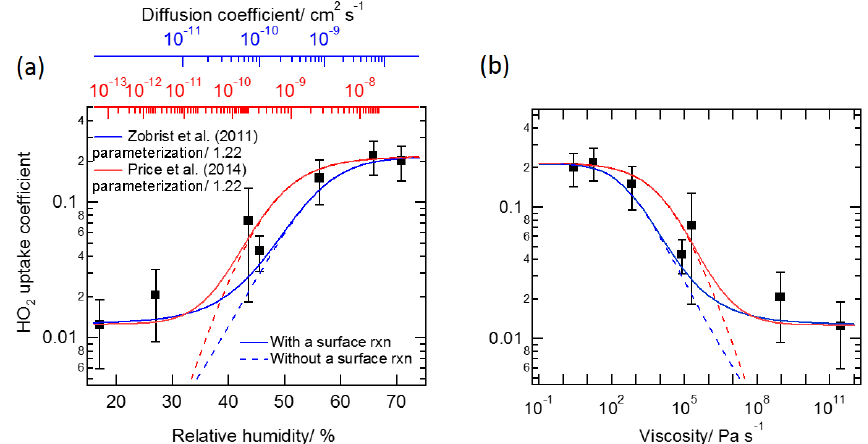
Figure 5. The HO 2 uptake coefficient onto copper (II)-doped sucrose aerosol particles as a function of (a) relative humidity and (b) aerosol particle viscosity. The lines represent the expected HO 2 uptake coefficient calculated using the KM-SUB model using the Price et al. (2014) (red) and Zobrist et al. (2011) (blue) diffusion parameterizations (see model description section) with (solid) and without (dashed) the inclusion of a surface reaction (Reaction R11). The viscosity within sucrose aerosol particles is based upon the data and fitting shown in Power et al. (2013) and Marshall et al. (2016), whilst the red and blue axes in (a) are the Price et al. (2014) and Zobrist et al. (2011) diffusion parameterizations, respectively. The error bars represent 2 standard deviations of the propagated error in the gradient of the k (cid:48) against aerosol surface area